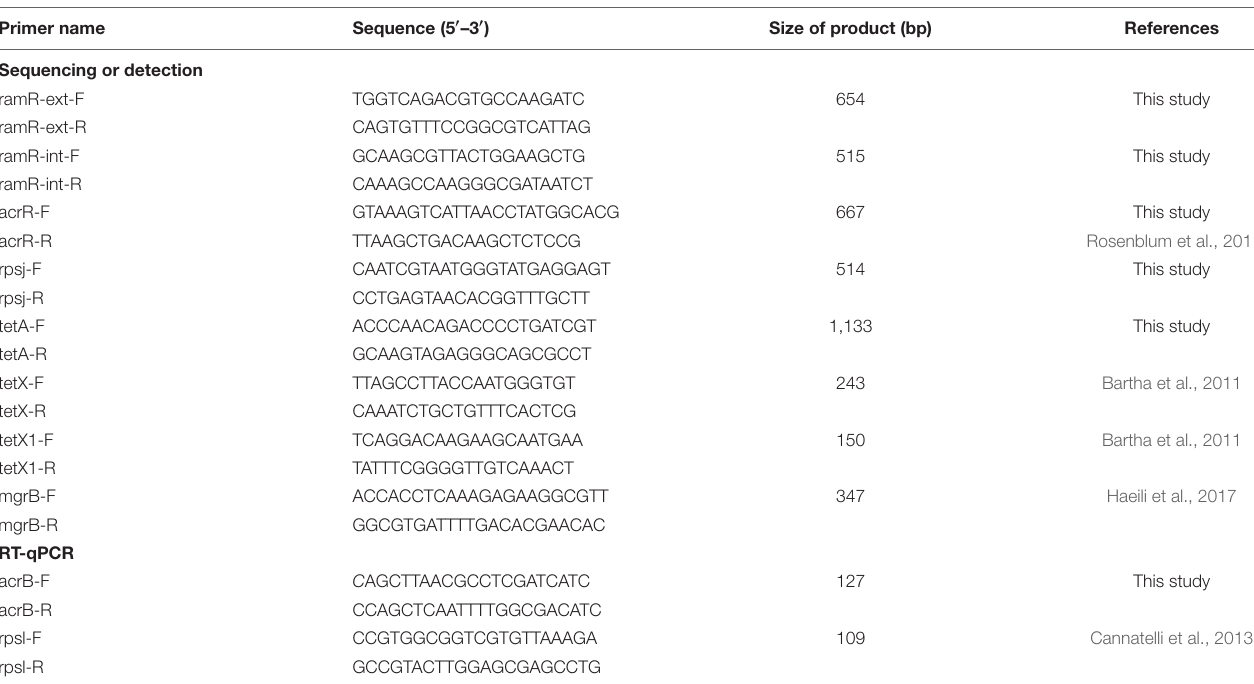
TABLE 1 | Nucleotide sequences of primers used in this